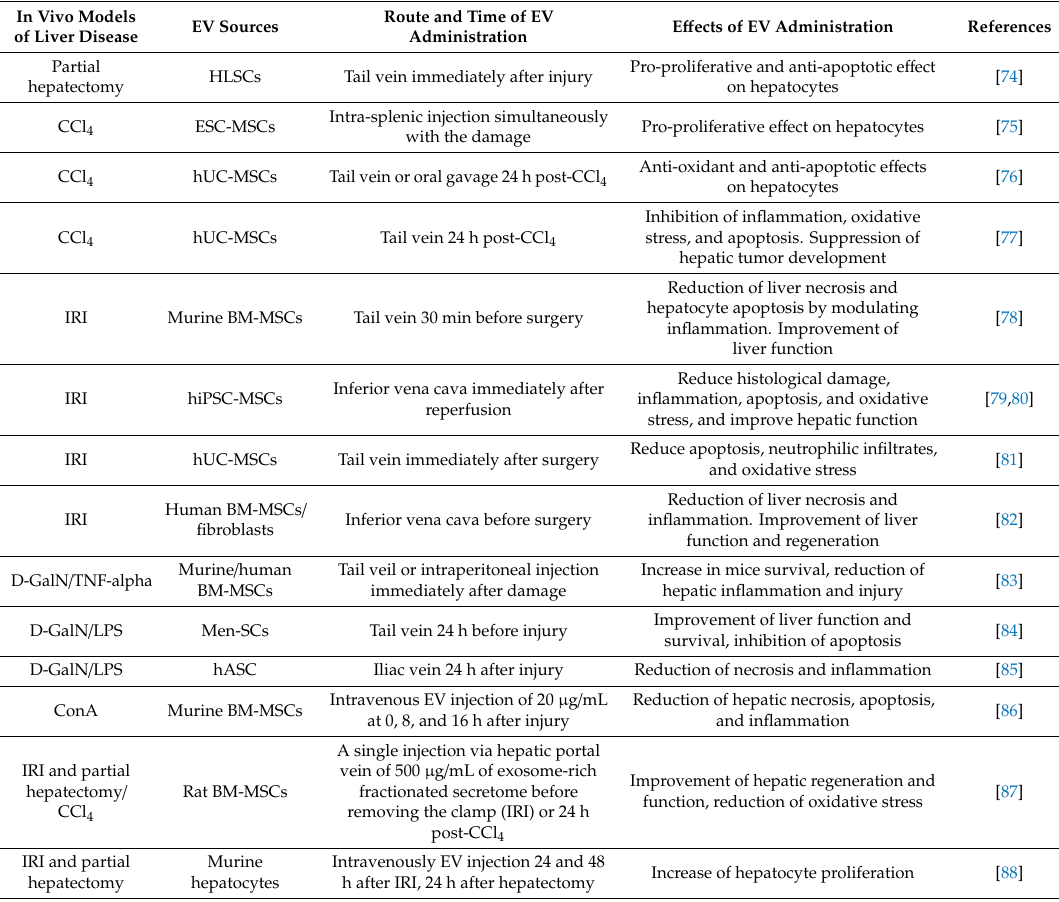
Table 1. E ff ects of extracellular vesicles (EVs) of di ff erent origins on di ff erent models of acute liver injuries. CCl4, carbon tetrachloride; IRI, ischemia-reperfusion injury; LPS, lipopolysaccharide; TNF, tumor necrosis factor; D-GalN, D-galactosamine; HLSC, human liver stem cell; MSC, mesenchymal stromal cell; ESC, embryonic stem cell; hUC, human umbilical cord; hASC, human adipose stem cell. In Vivo Models Route and Time of EV EV Sources E ff ects of EV of Liver Disease Administration